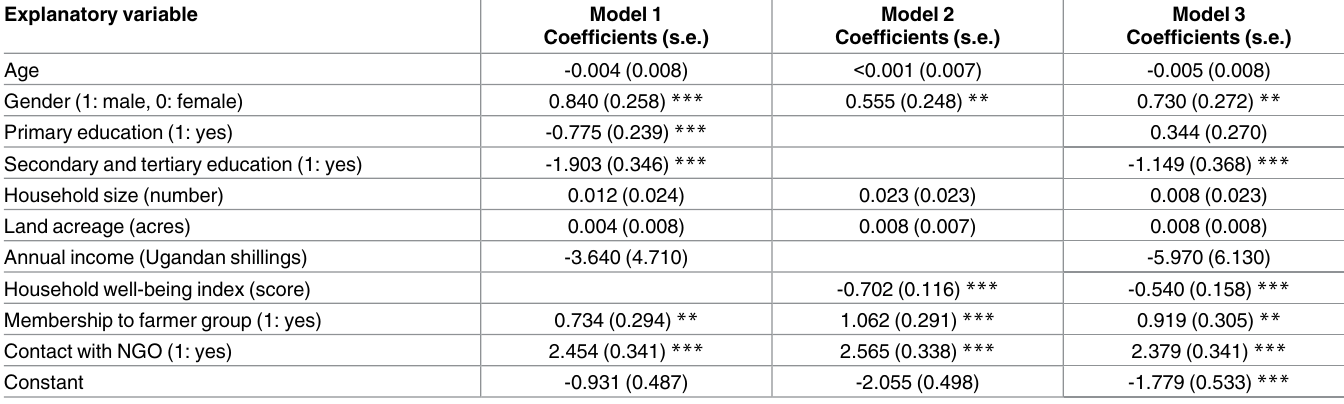
Table 5. Step 1: Probit estimation of socio-economic predictors of beekeeping